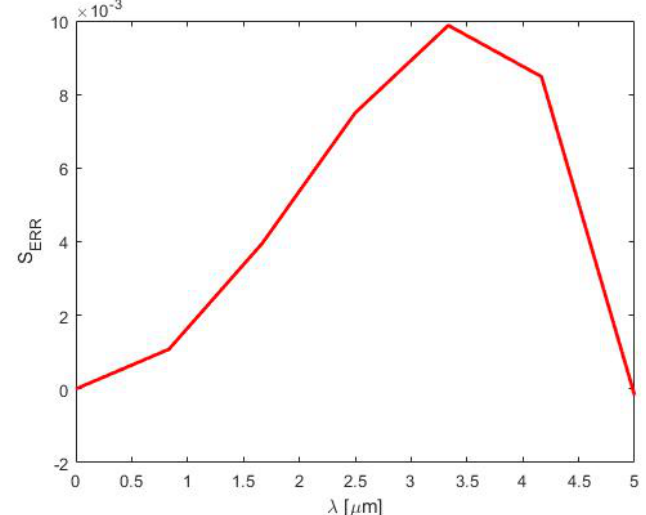
Figure A3. The difference between the spectral response with 1% error in the voltage and without it using the power series